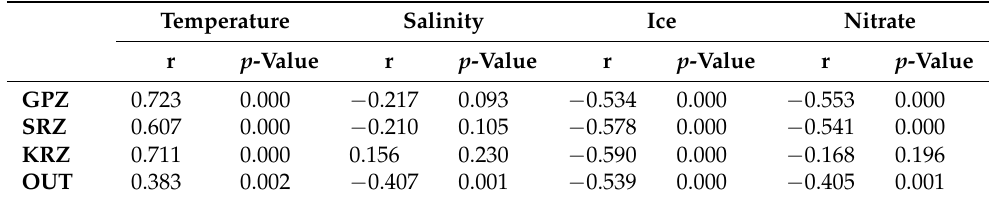
Table 2. Correlation coefficients of phytoplankton biomass and other environmental variables in different MPA regions and outside in February.